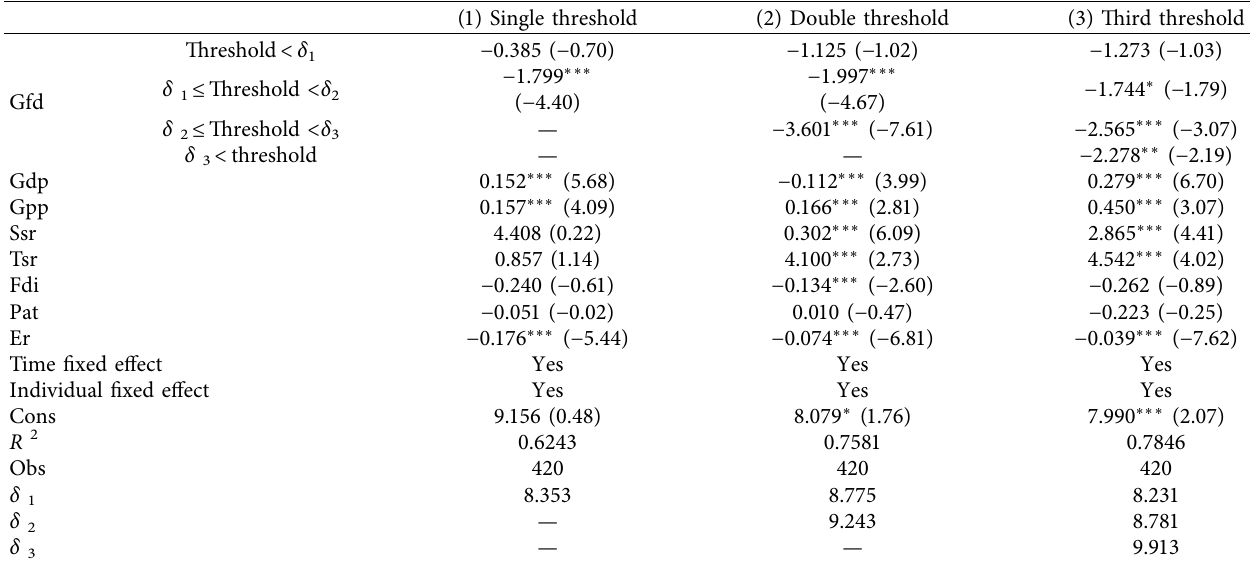
Table 8: Threshold effect regression